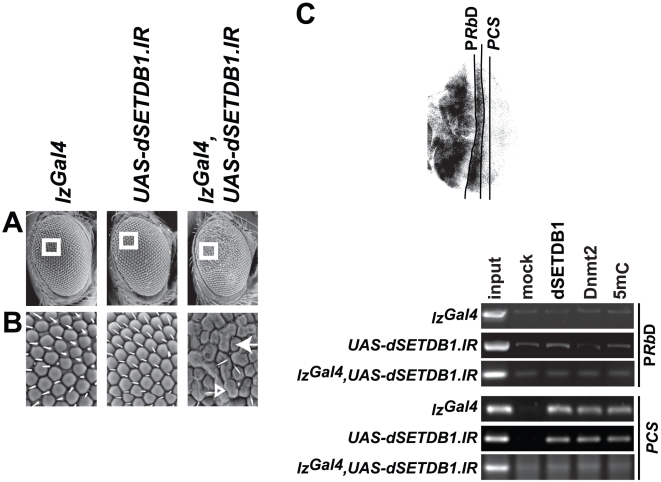
DSETDB1-mediated DNA methylation mediates silencing of Rb in the developing eye.(A) Scanning electron micrographs showing the adult eye phenotype of lzGAl4, UAS-dSETDB1.IR and lzGAL4;UAS-dSETDB1.IR flies (50-fold magnification). (B) Magnification of the areas marked by white rectangles in (A) (1,000-fold total magnification). The arrowhead marks the position of fused ommatidia and the arrow the position of misshaped ommatidia. (C) (Top) Digital photograph showing Rb transcription in eye imaginal disc. The position of the posterior Rb transcription domain (PRbD) and posterior cell stripe (PCS) are indicated. (Bottom) Digital images of ethidium bromide-stained agarose gels detecting the PDE of Rb in DNA pools obtained by ChIP. Chromatin was isolated from cell stripes representing the PRbD and the PCS of imaginal discs isolated from third-instar lzGAl4, UAS-dSETDB1.IR, and lzGAL4;UAS-dSETDB1.IR larvae. Chromatin was immunoprecipitated with antibodies to dSETDB1, Dnmt2, 5mC or rabbit serum (mock). Input represents the amount of target DNA present in 4% of the chromatin used for ChIP.